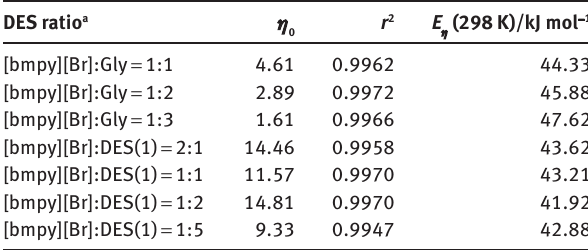
Table 2: Fitting parameters of the viscosity data to Arrhenius model.